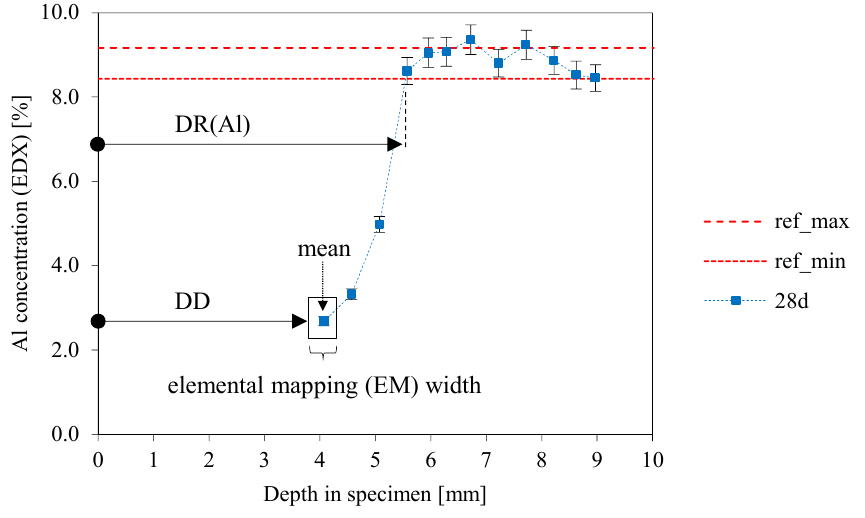
Figure 3. Method of determining the depth of reaction DR(e) of geopolymer elements (SEM-EDX elemental mapping).